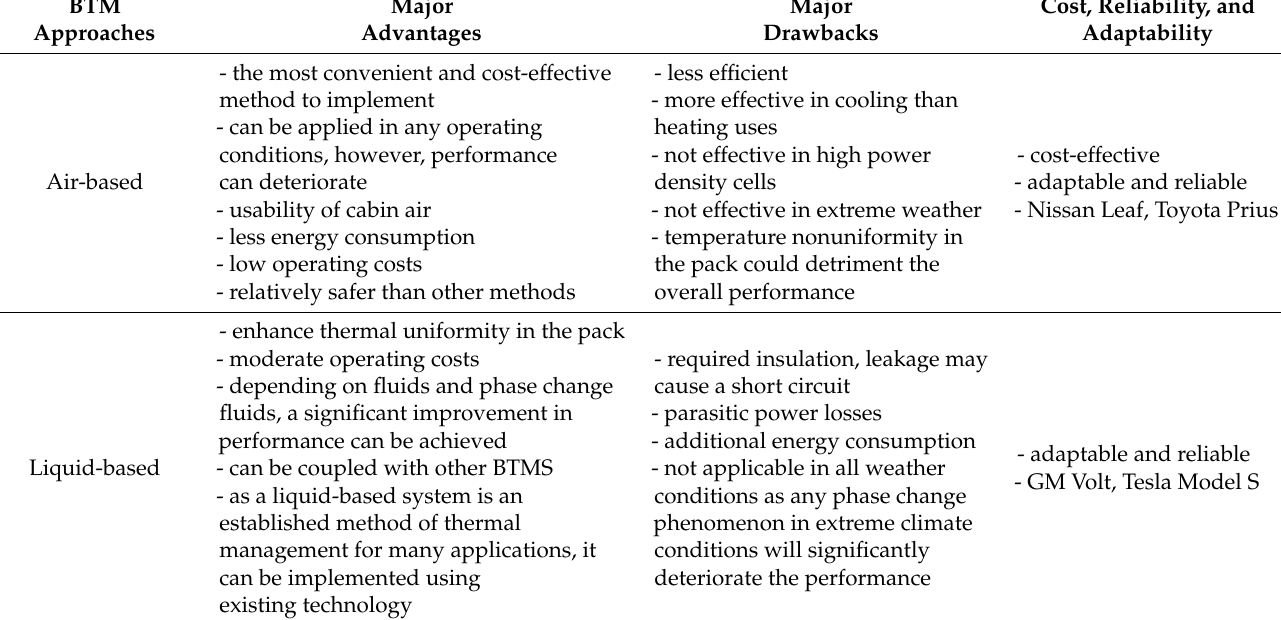
Table 7. Comparative analysis of different battery thermal management